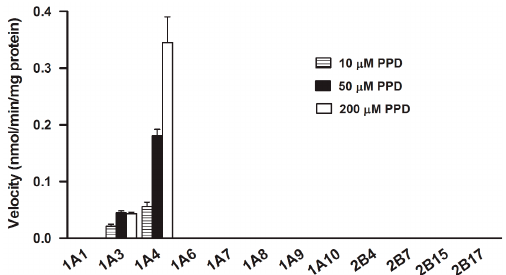
Figure 5. Assays of glucuronidation activities of PPD (10, 50, and 200 μ M) catalyzed by different recombinant UGT isozymes (0.25 mg/mL). Data were obtained from three replicates.